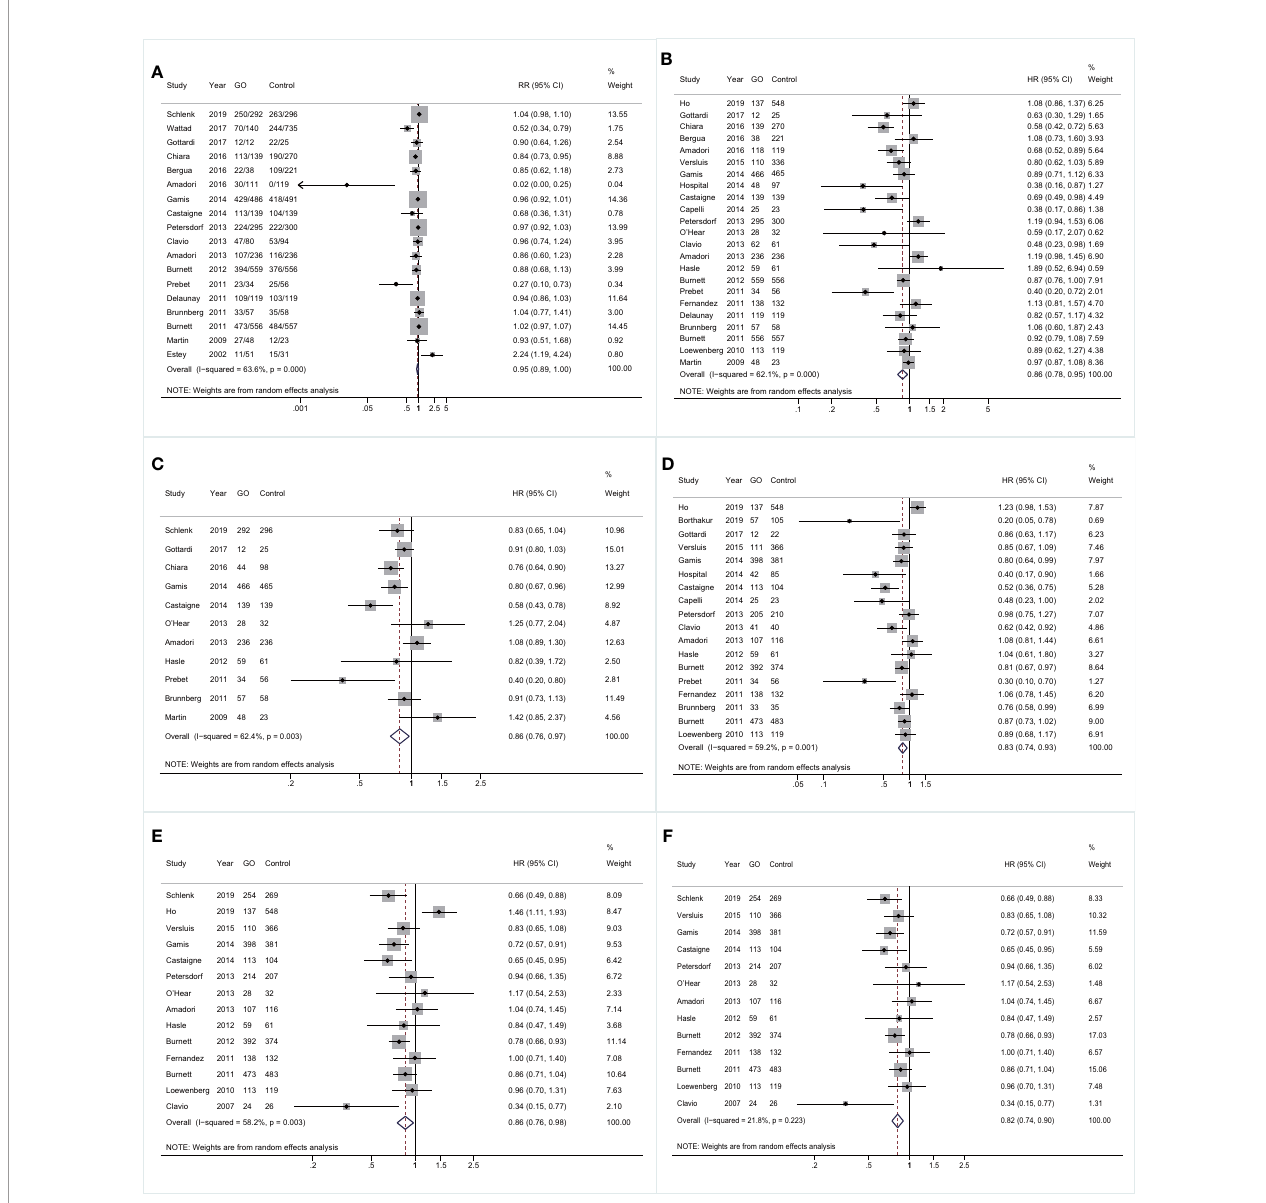
FIGURE 1 | Pooled prognosis between GO and non-GO groups with AML. (A) Pooled CR. (B) Pooled OS. (C) Pooled EFS. (D) Pooled RFS. (E) Pooled CIR. (F) Pooled CIR after sensitivity analyses. The diamonds represent the overall summary RR and HR estimates with 95% CI. GO, gemtuzumab ozogamicin; AML, acute myeloid leukemia; CR, complete remission; OS, overall survival; EFS, event-free survival; RFS, relapse-free survival; CIR, cumulative incidence of relapse; RR, relative risk; HR, hazard ratio; 95% CI, 95% con fi dence